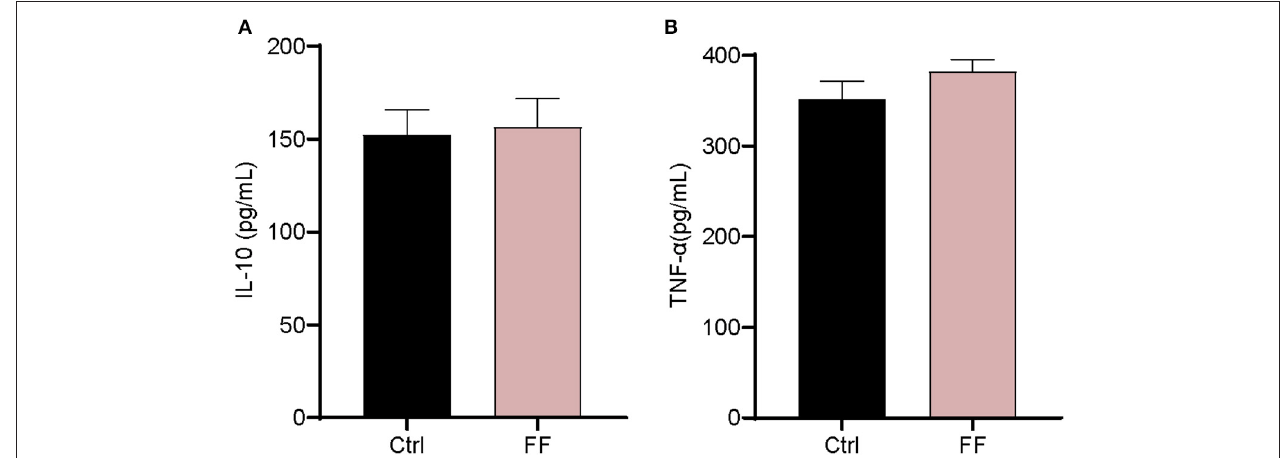
FIGURE 3 | Effect of FF on the serum cytokine levels. (A) IL-10; (B) TNF- α . Ctrl: pigs fed with normal commercial feed; FF: pigs fed with fermented meal. Data are presented as mean ± SEM ( n = 6).